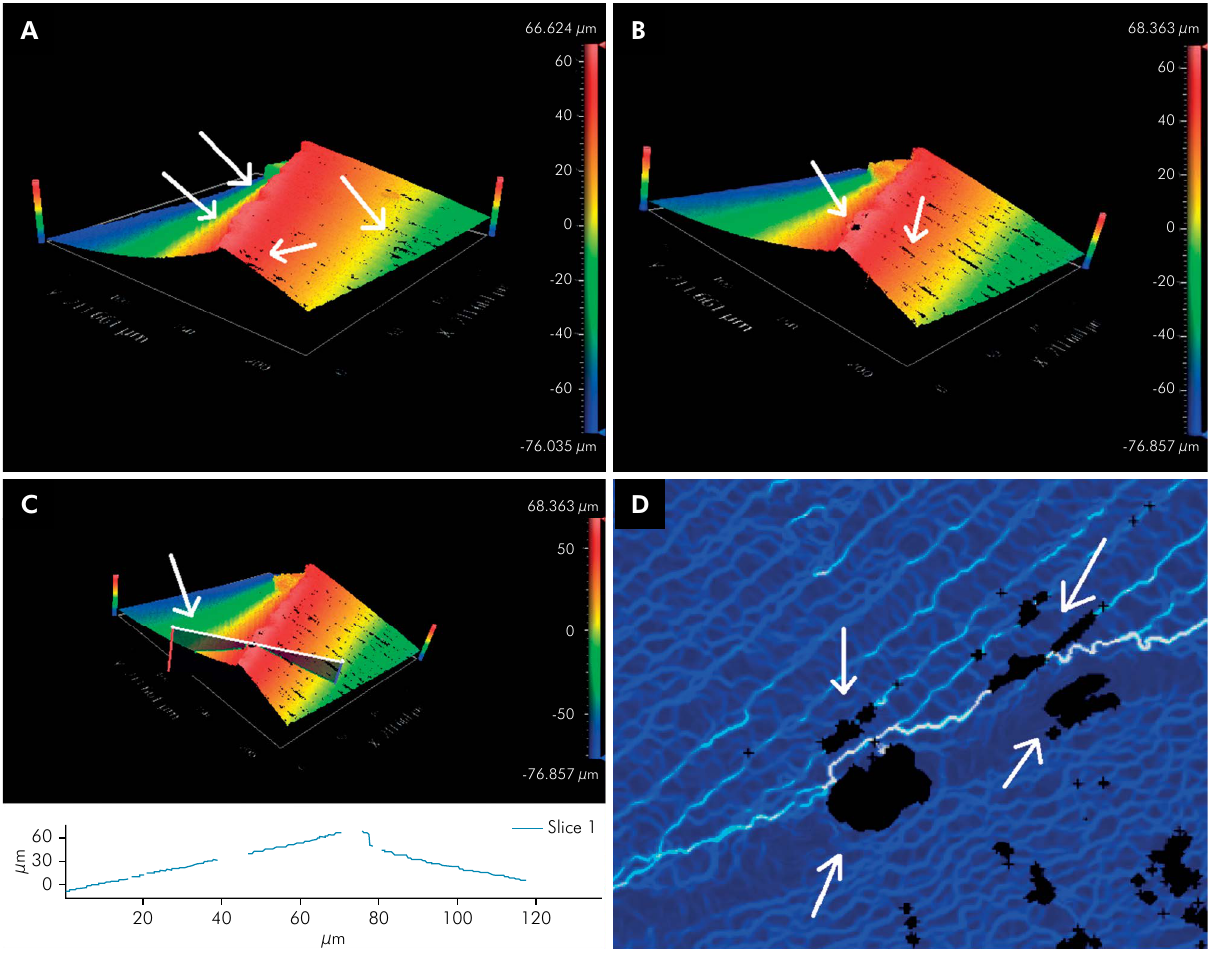
Figure 3. Optical profilometry characterization of irregularities (white arrows) on the cutting blade surface of a WaveOne instrument: (a) instrument surface showing milling marks, grooves, steps, pits and microvoids before use; (b) crack propagation after the second use; (c) transversal slice applied on the crater and crack propagation in the three-dimensional image of the surface with a profile graphic representation of the slice area showing disruptions on the analyzed surface; (d) propagation of cracks parallel to the local fluting orientation under connected pitted regions and an increased crater on the cutting edge border after the second use of the